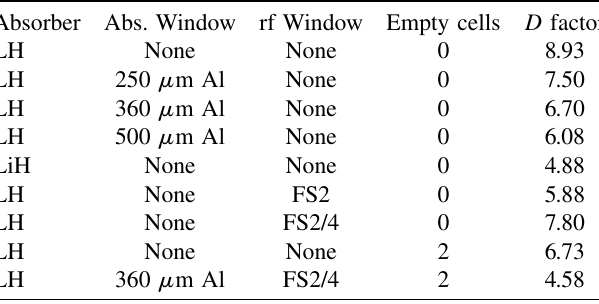
TABLE III. Perturbations on the ideal ring performance. FS2 stands for windows used in Study 2; FS 2 = 4 stands for windows used in FS2 with thicknesses reduced by a factor of 4.